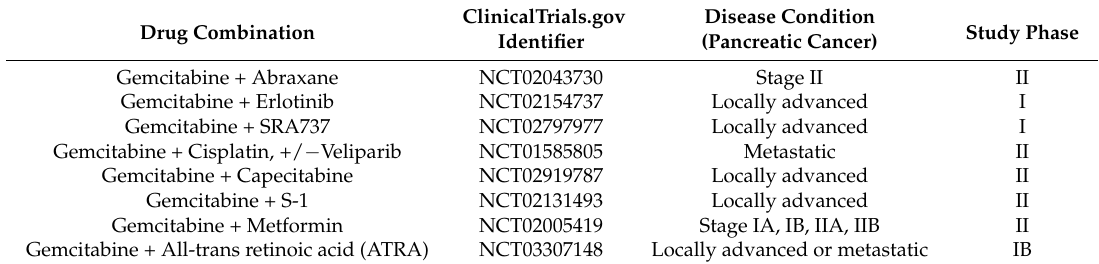
Table 3. Ongoing clinical trials for gemcitabine-based combination therapies in pancreatic